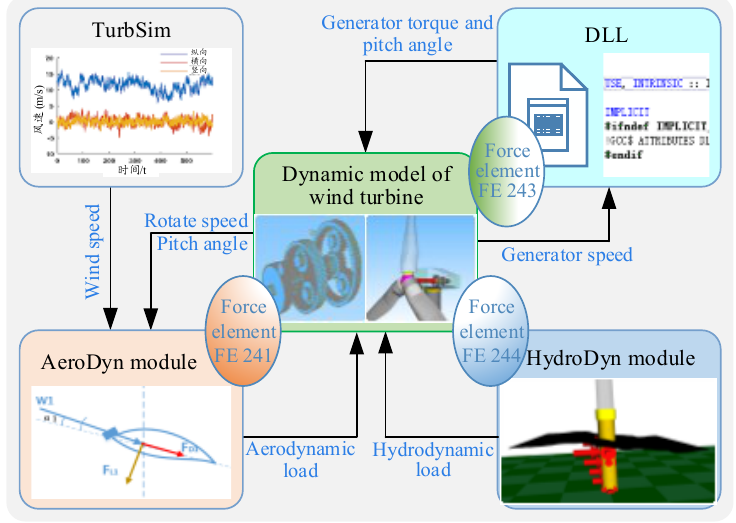
Figure 6. Simulation flow chart of wind turbine